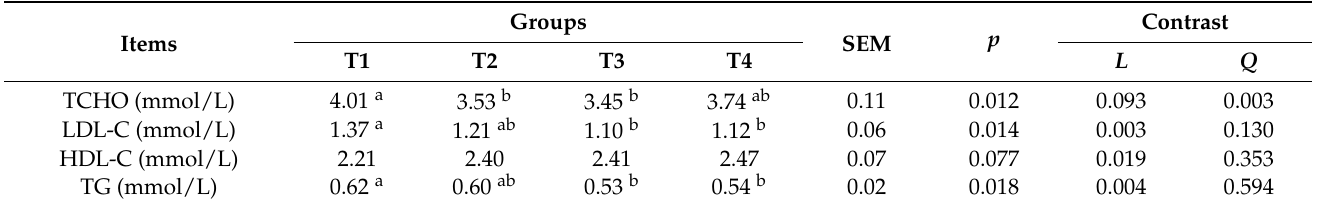
Table 2. Effects of Ampelopsis grossedentata extract on the serum lipids parameter of broilers.